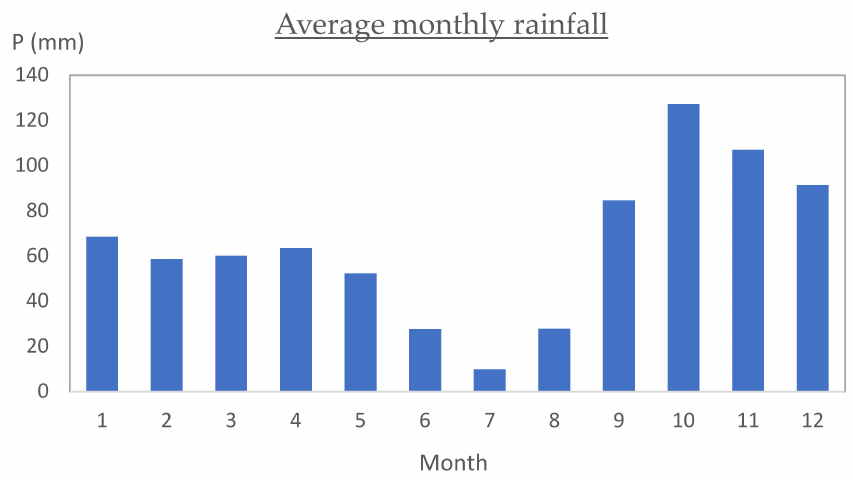
Figure 5. Average precipitations per year in the area under